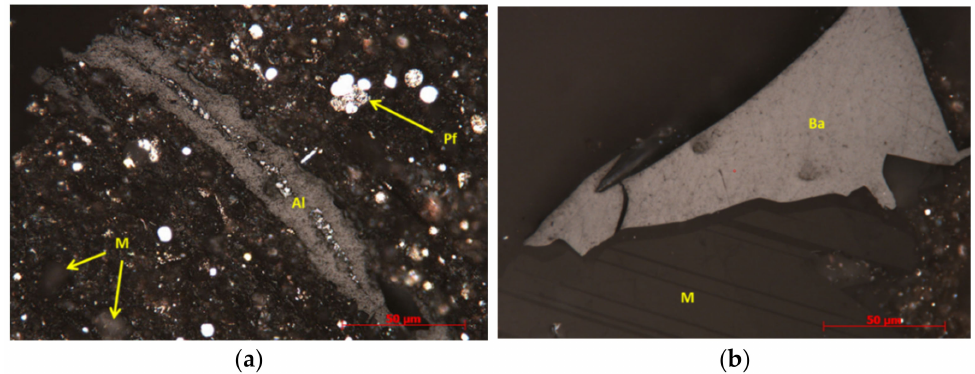
Figure 3. Photomicrographs of Marcellus Formation organic matter in Upshur County, West Vir- ginia. Measured VRo = 2.37%. ( a ) Thermally transformed amorphous organic matter (AOM) with background matrix, mineral grains (M), framboidal pyrite (Pf) and interpreted algal body (Al). ( b ): Angular pyrobitumen (Ba) and interface with mineral matrix. Inert AOM comprises 46.1 to 57.9% of the kerogen. Solid hydrocarbon makes up between 25 and 40% of the organic matter. Conversion of AOM to hydrocarbon is estimated between 84.2 and 92.7%. Photomicrographs, composition interpretation, and VR o measurements by Dr. Wayne Knowles, Stratum Laboratories,